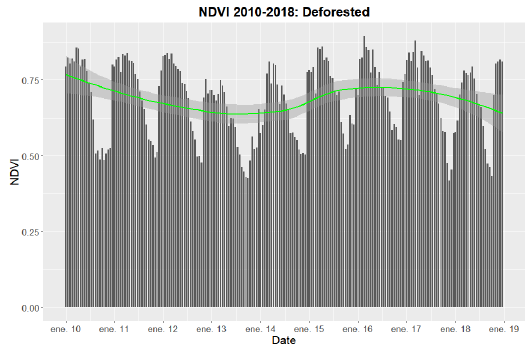
Figure 5. NDVI time serie of the deforested area. The green line shows the result of the LOESS local regression.